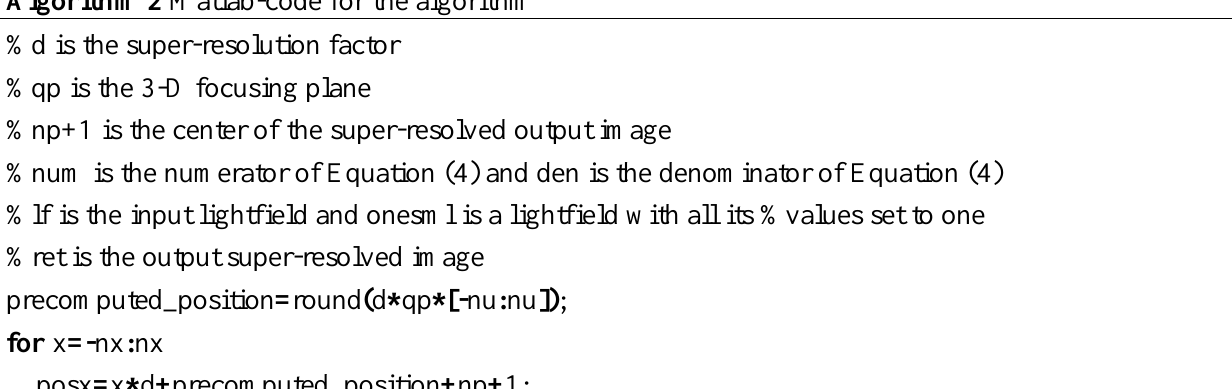
Algorithm 2 Matlab-code for the